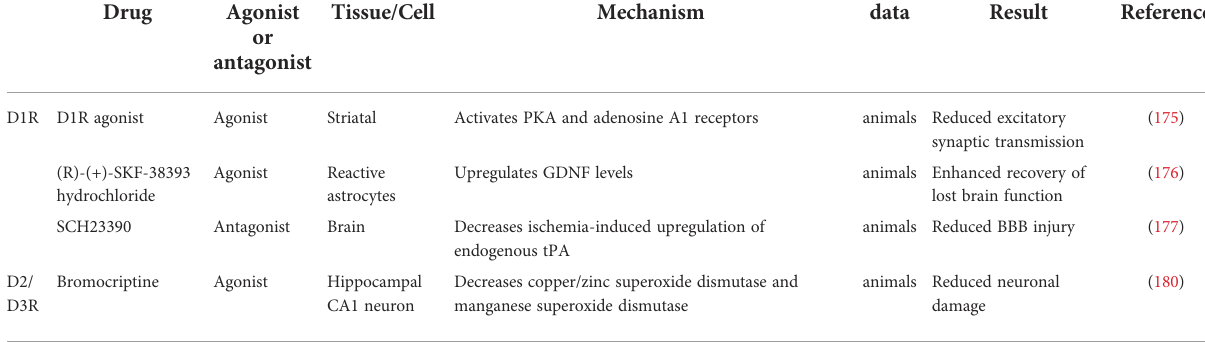
TABLE 3 Mechanism of D1R and D2R/D3R agonists and antagonists on ischemic